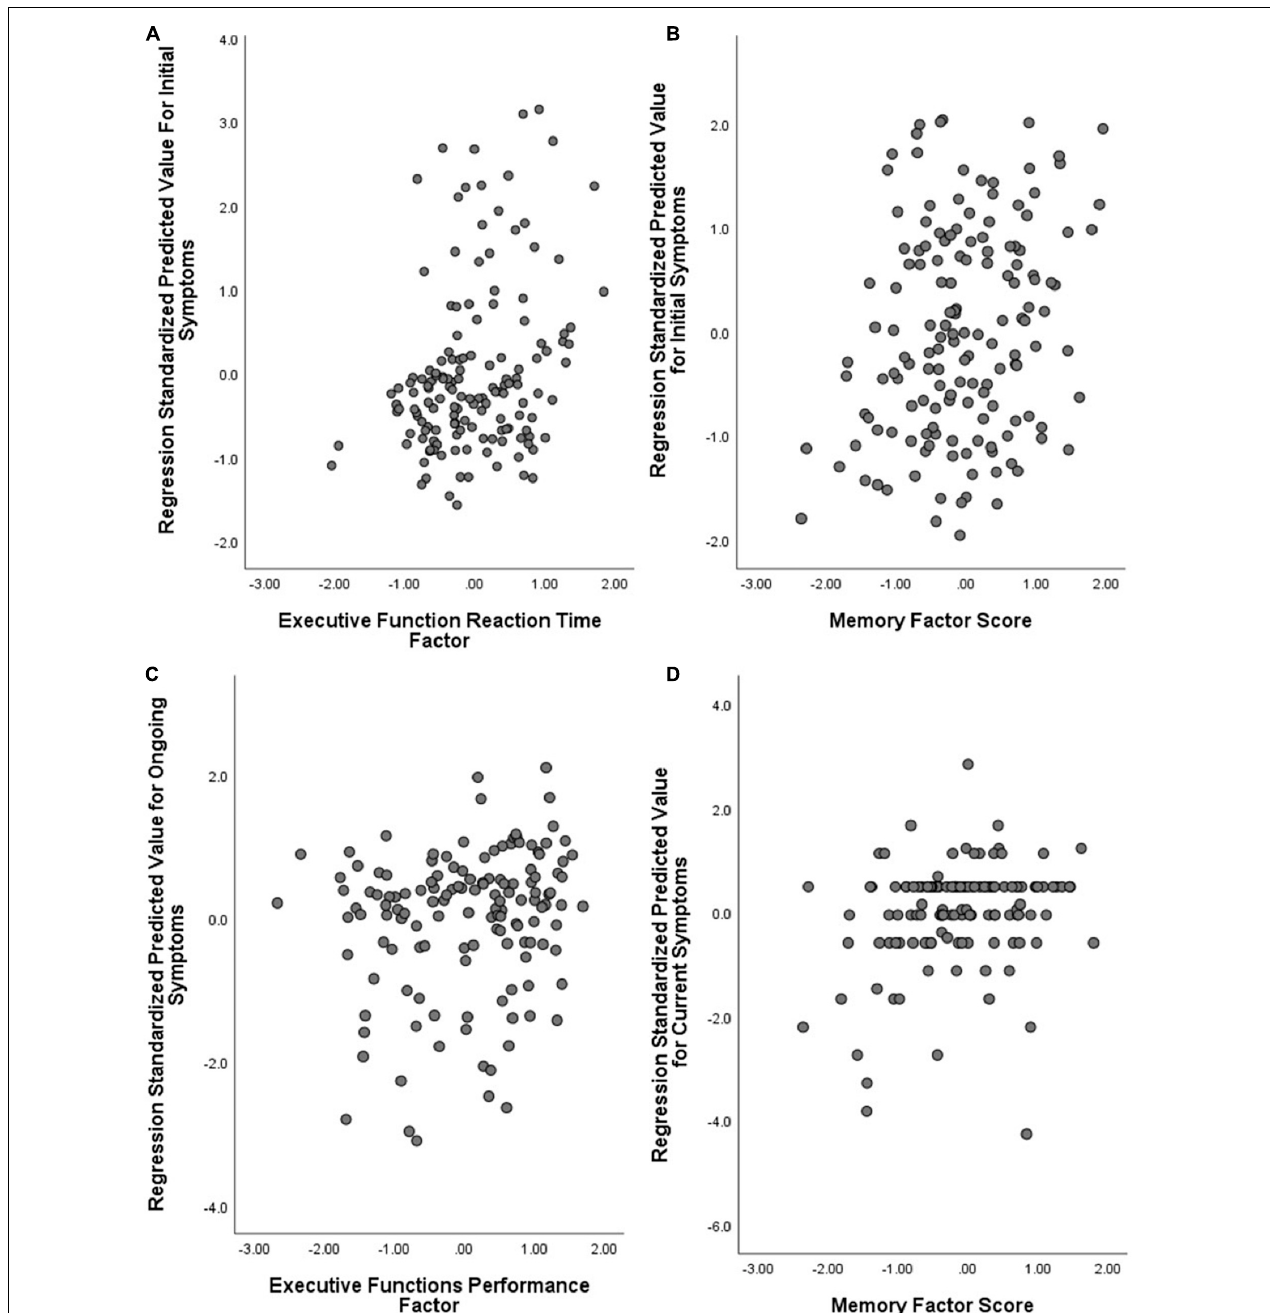
FIGURE 4 | Symptom factors predicting cognitive task factors. (A) Initial symptoms model (Dermatological) predicting Executive Function Reaction Time; (B) Initial symptoms model (Fatigue/Mixed) predicting Memory; (C) Ongoing symptoms model (Neurological) predicting Executive Function Performance; and (D) Current symptoms model (Neurological) predicting Memory. Note that symptom factors are reversely coded (lower numbers translate to more severe symptoms).